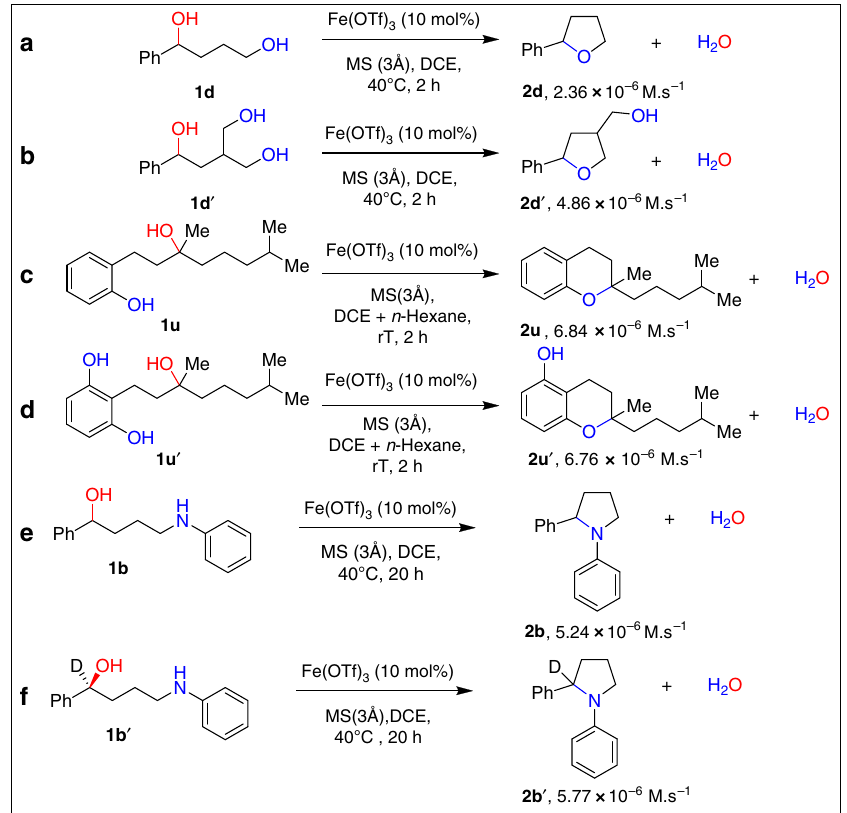
Fig. 4 Control experiments. a – d Comparative studies for the rate-order determination of the reaction with respect to nucleophiles. Reaction conditions : The alcohol (0.5 mmol), DCE (2 mL), and catalyst (10 mol%) were heated in an oil bath at the desired temperature. Initial rates were determined at conversions below 20% (up to 2 h) by 1 H NMR spectroscopy. Each value is the mean of two runs. e and f show rate constant and deuterium kinetic isotope effect for 1b and 1b